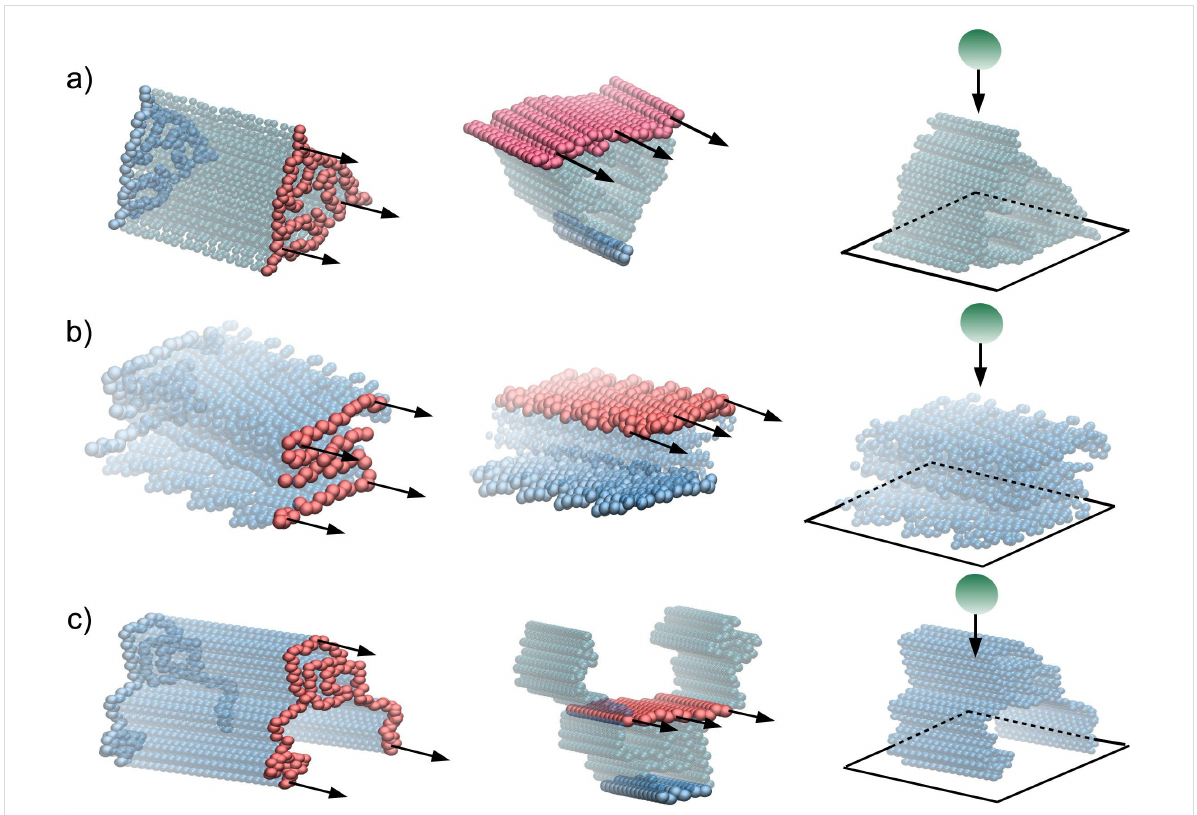
Figure 3: For the cases of Figure 1, we present schematically each deformation process. The left panels show tensile, the middle panels shearing, and the right panels indentation processes. The set of C α atoms anchored in each processes are shown in blue, the ones which are moving at a speed v pull are shown in red, and the indenter bead in green. Arrows indicate the direction of pulling. In the case of indentation, a potential z 0 − 10 has been used to model the basis plane, where z 0 is the distance between the plane and the CG beads. (a) A β 40 (PDB ID: 2M4J), (b) A β 40 (PDB ID: 2LMO) and (c) α -syn (PDB ID: